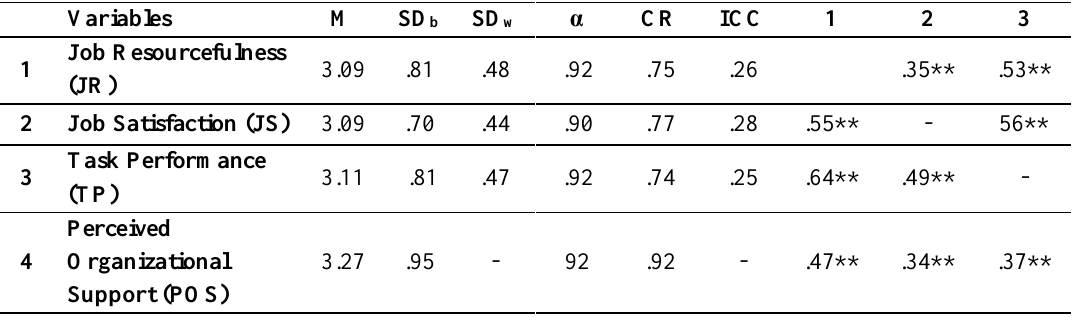
shows the means, level-specific